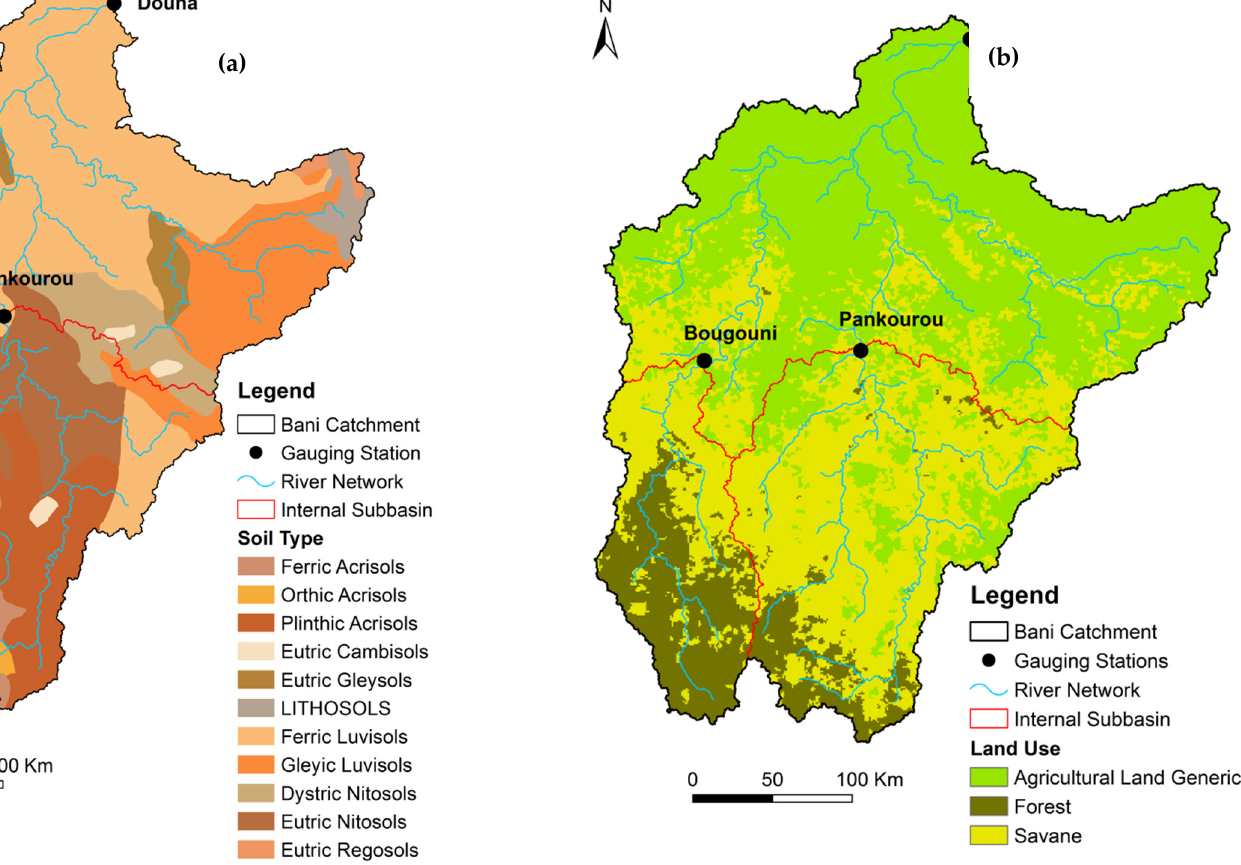
Figure 2. ( a ) Soil attributes and ( b ) land use categories of the Bani catchment.